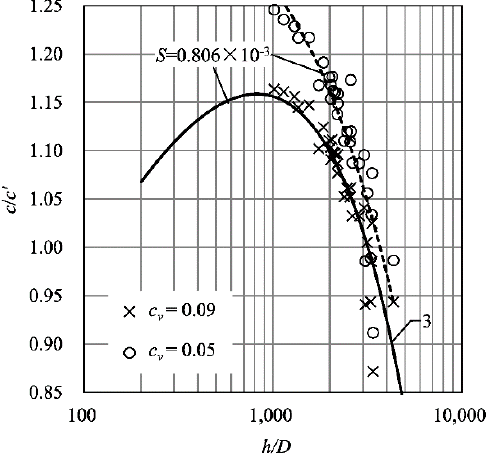
Figure 13. The relation of the resistance factor ratio c / c ′ to the relative depth h / D with different values of c v .